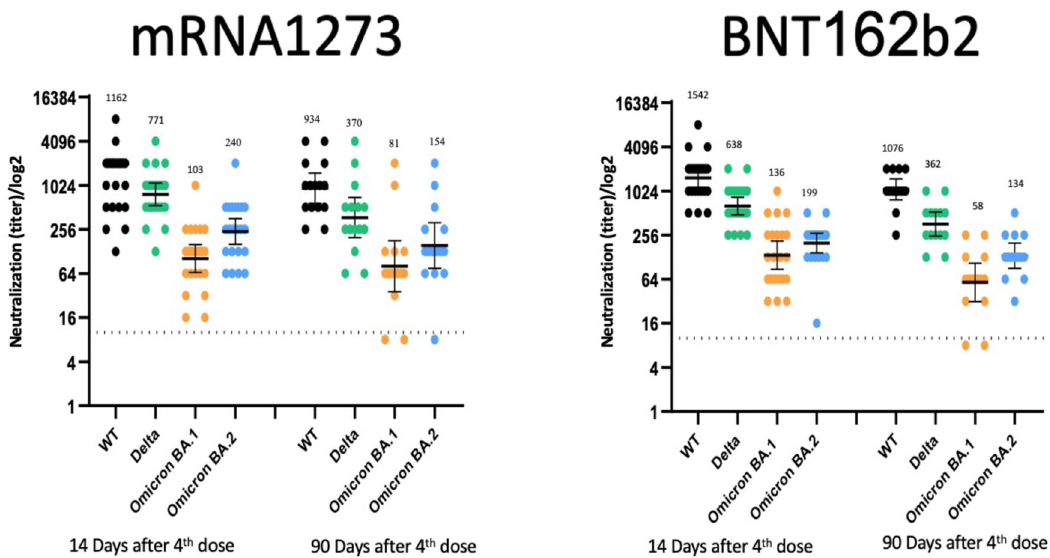
Fig. 3 | Direct neutralization titers against different strains. Live virus neu- tralization ef fi ciencyfollow-up at14-and 90-days post-vaccination withmRNA1273 orBNT162b2fourthdosevaccinesagainstdifferentstrains[Indexvirus,DeltaVOC, Omicron BA.1 VOC, and Omicron BA.2 VOC] (for mRNA1273: n =21 and n =14, for